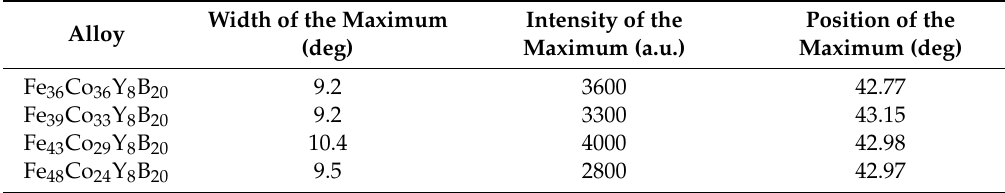
Position of the Maximum